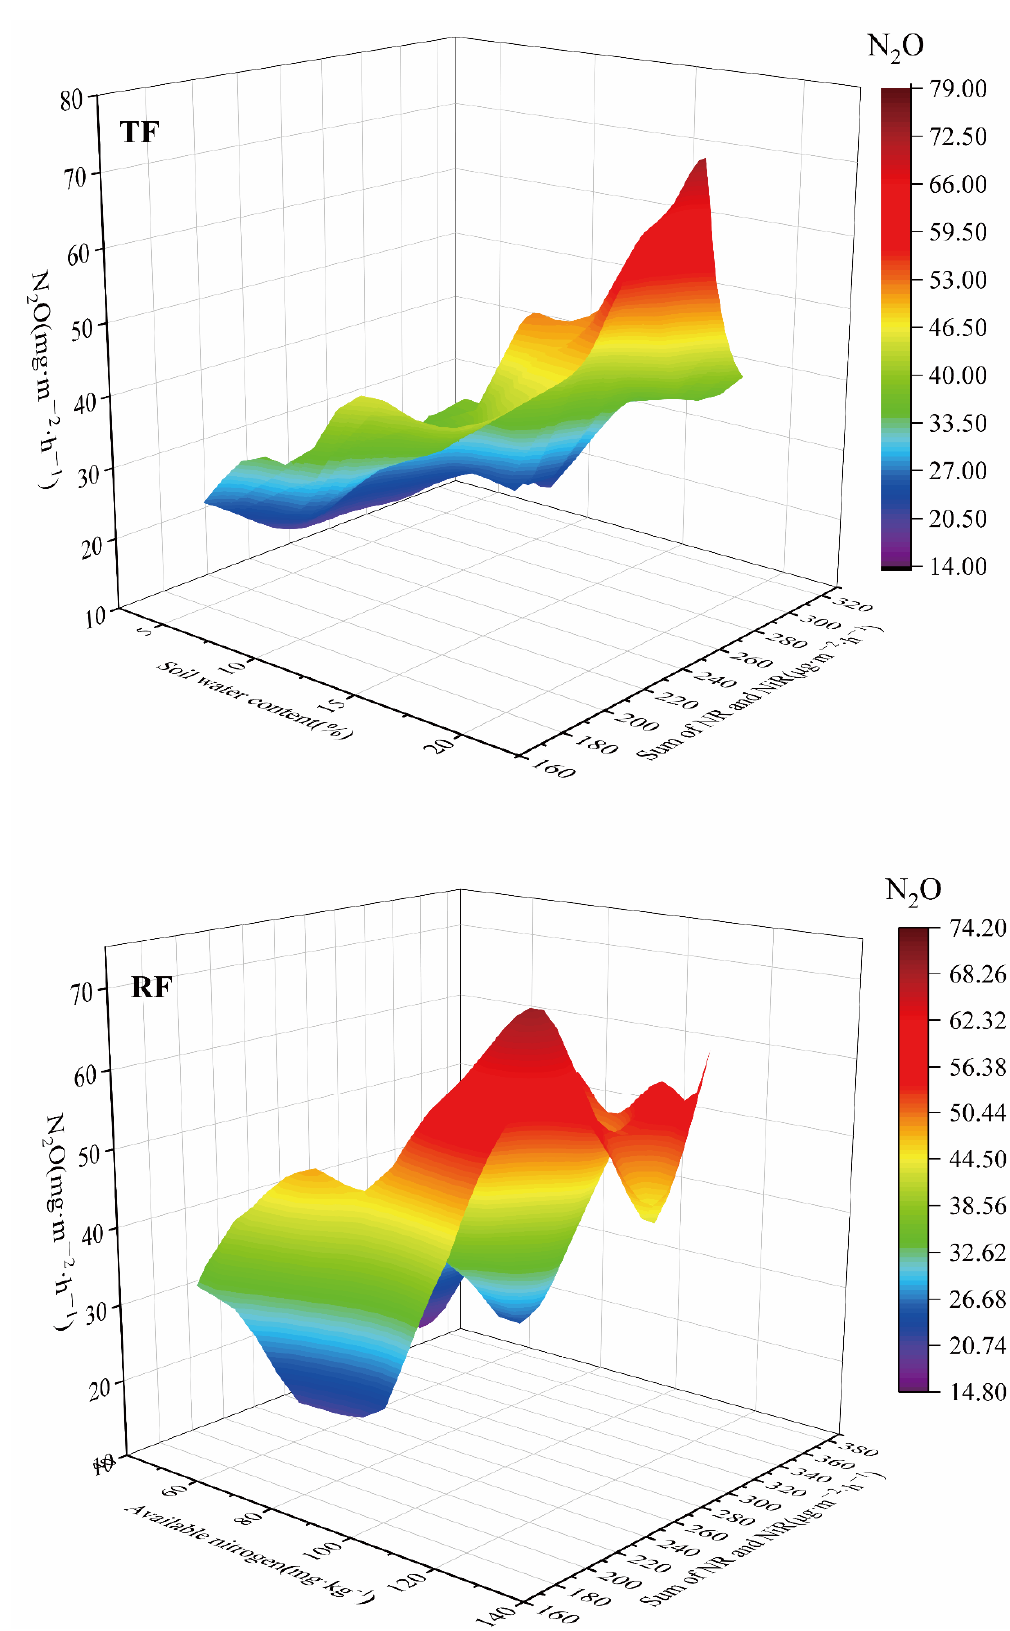
Figure 6. Fitting of principal components to N 2 O emission flux under RF and TF.